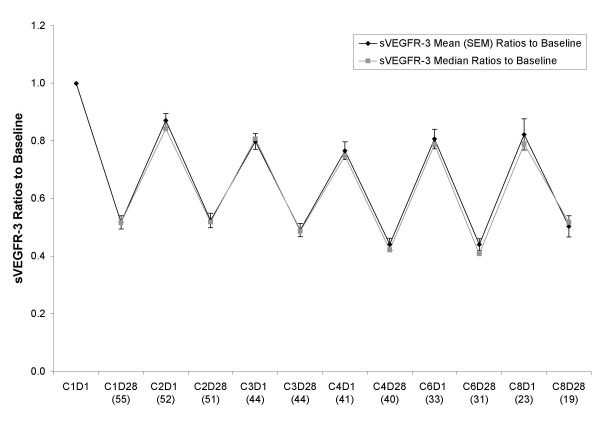
Mean and median ratios to baseline for sVEGFR-3 at each timepoint in various treatment cycles. The format follows the same convention as in Figure 1.